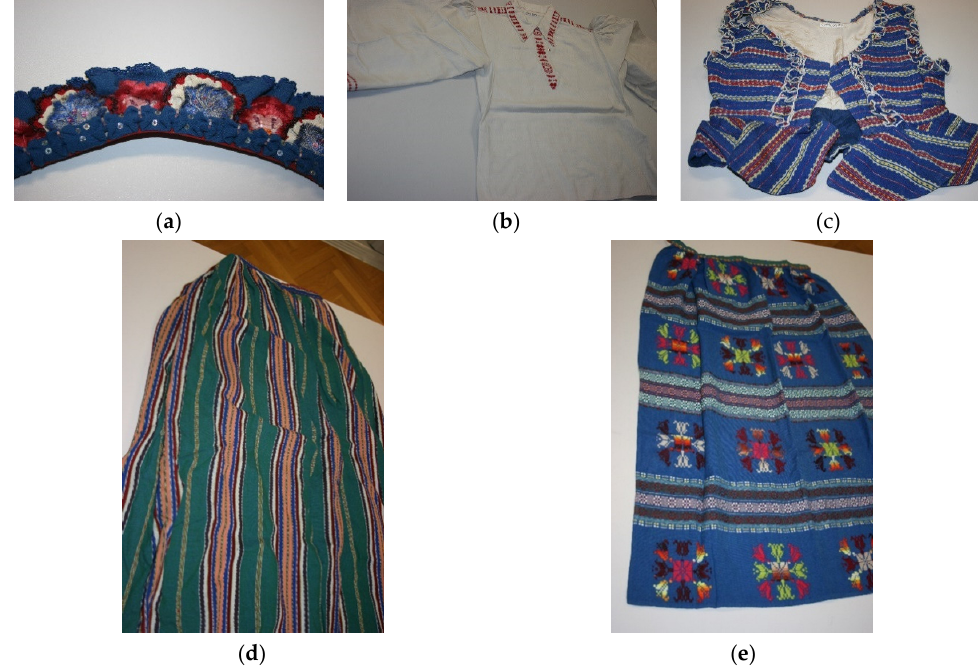
Figure 20. National costume from Suvalkija made by the company “Marginiai” in 1942: ( a ) Crown ˇCDM E6320; ( b ) shirts ˇCDM E6319; ( c ) vest ˇCDM E6318; ( d ) skirt ˇCDM E6316; ( e ) apron ˇCDM